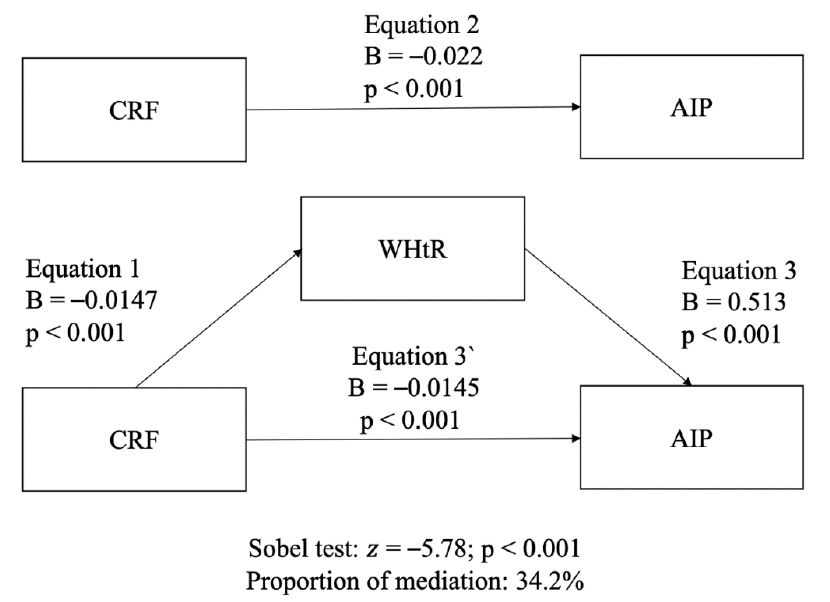
Figure 2. The mediation effect of the WHtR on the association between CRF and the AIP adjusted for potential confounders (age, sex, tobacco, alcohol consumption, and educational level). CRF: cardiorespiratory fitness; WHtR: waist-to-height ratio; AIP: atherogenic index of plasma. B represents unstandardized